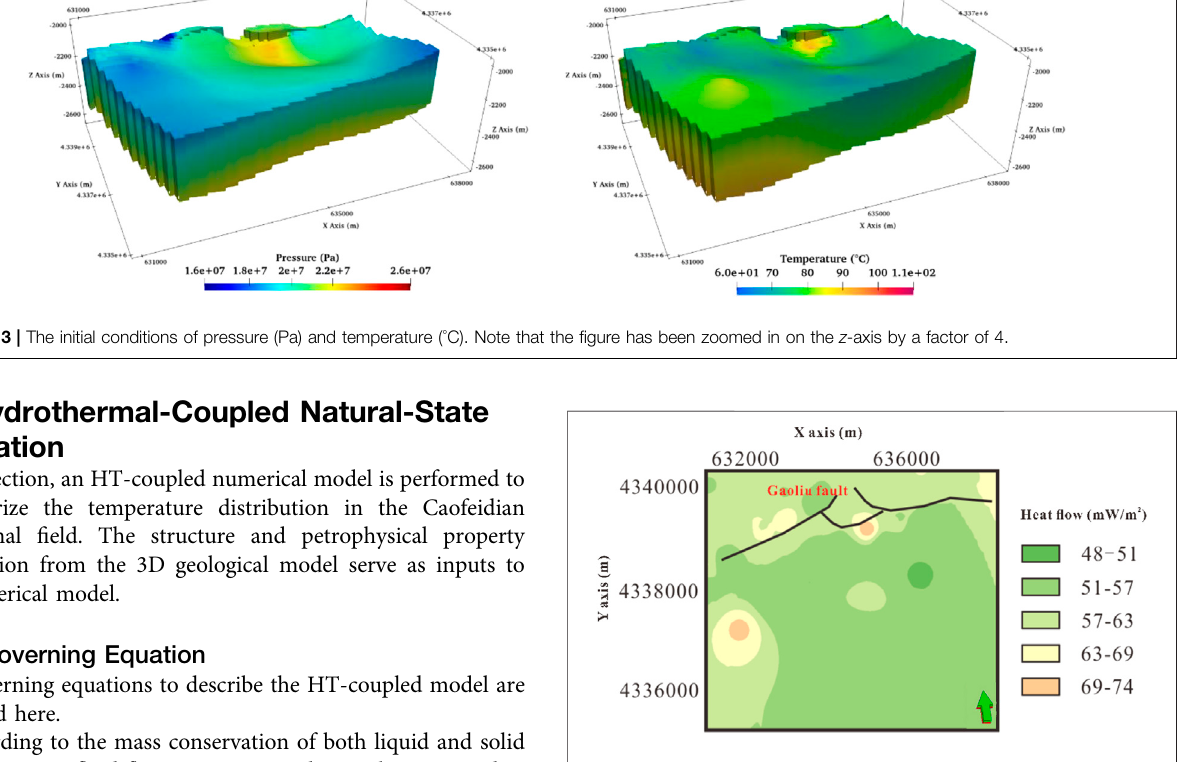
FIGURE 4 | The heat fl ow distribution in the study